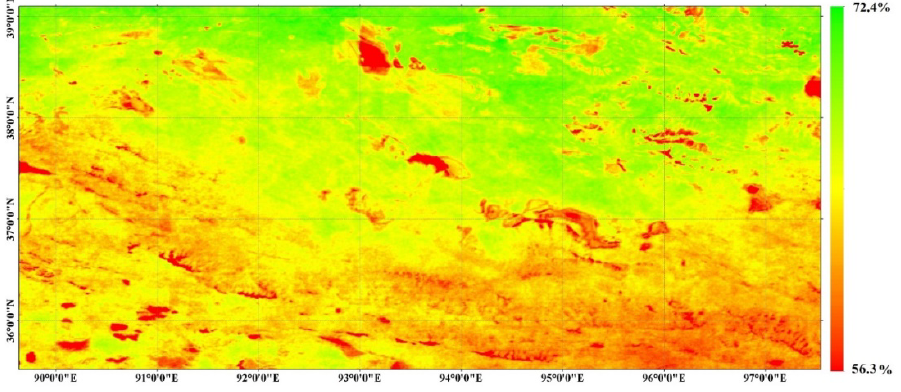
Fig. 4. Clear nights rate of the study area from October 2016 to October